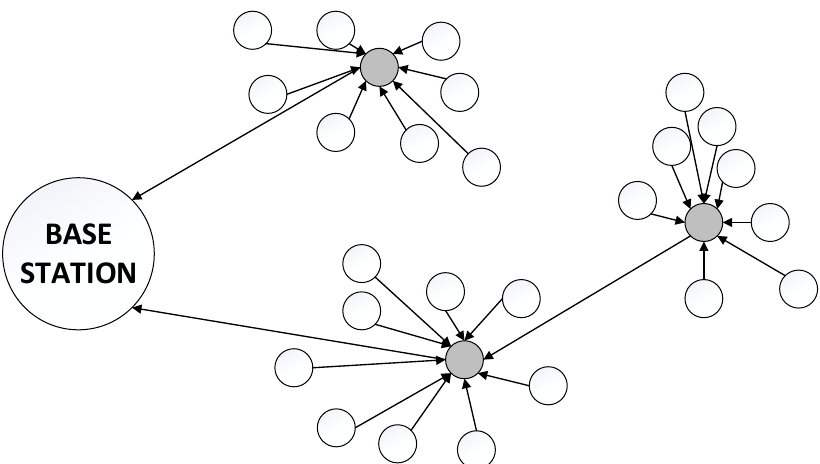
Figure 2. The general architecture of a Clustered WSN.